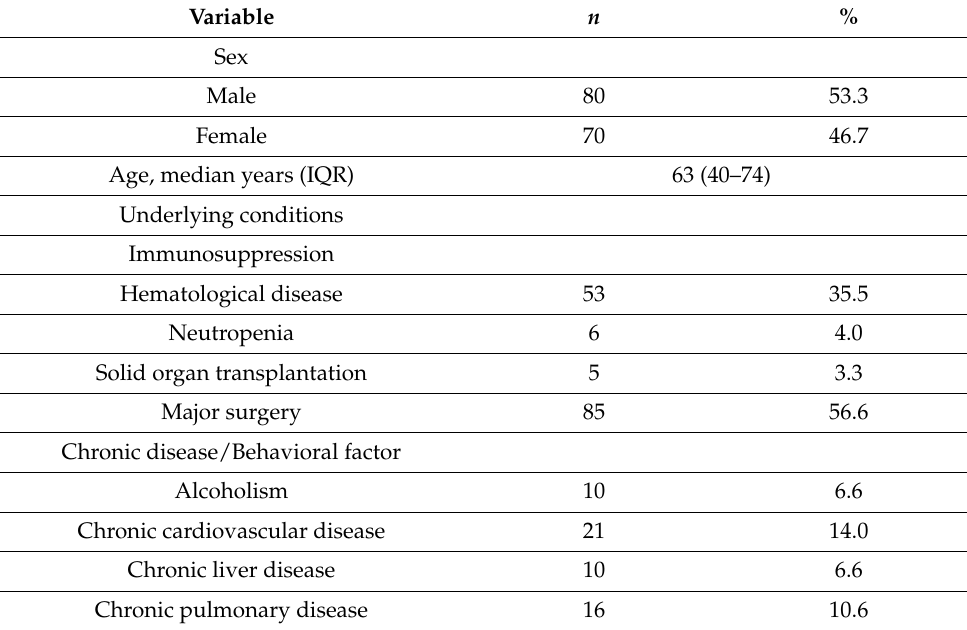
Table 2. Baseline characteristics and risk factors of 150 patients with MY